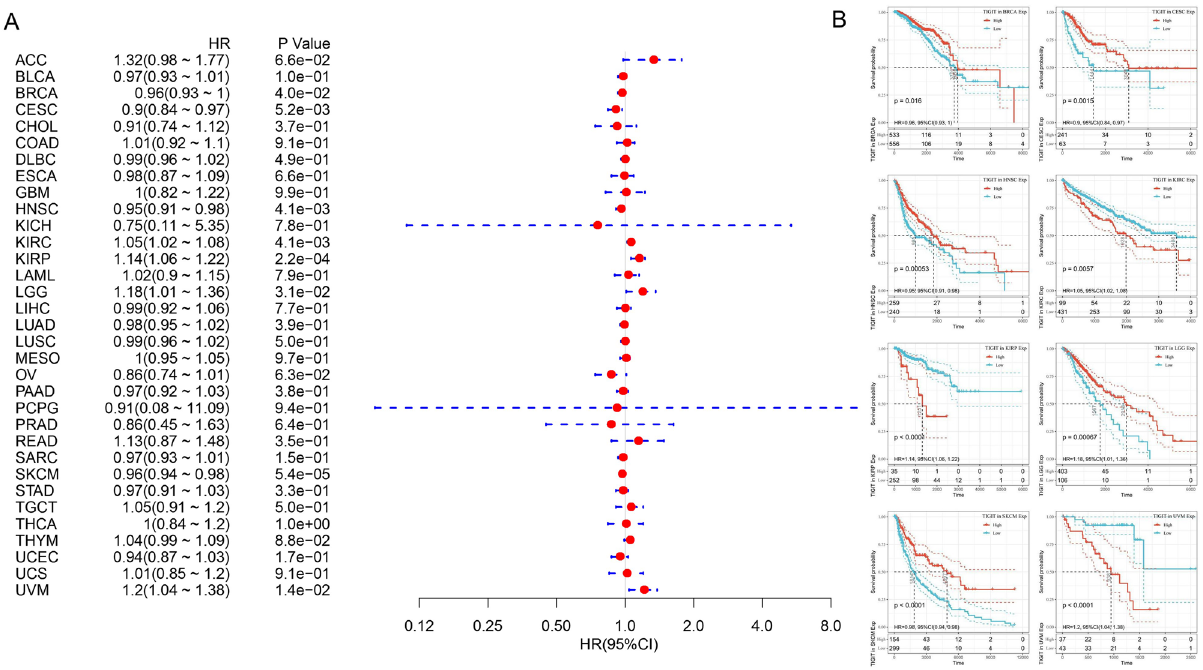
Figure 2. Selected Kaplan–Meier plots and forest plot comparing the high and low expression of TIGIT on overall survival (OS) across different cancers ( A ) Forest plot exhibiting the influence of high expression of TIGIT on OS across thirty three cancer types using Cox regression model. ( B ) Kaplan–Meier survival curves comparison of high and low expression of TIGIT for the OS analysis for BRCA, CECS, HNSC, KIRC, KIRP, LGG, SKCM and